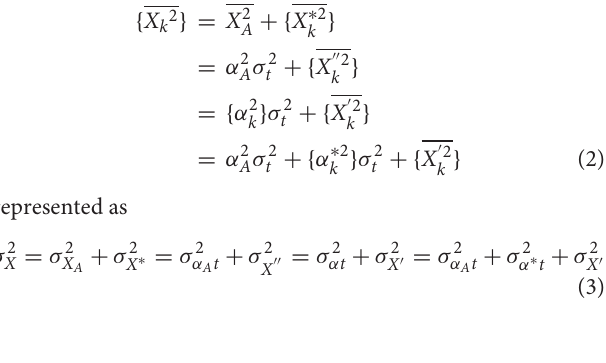
FIGURE 2 | (A) Linear trends α k and (B) standard deviations analyses (gray). The red bar is (A) the trend α A of the ensemble mean and (B) the standard deviation